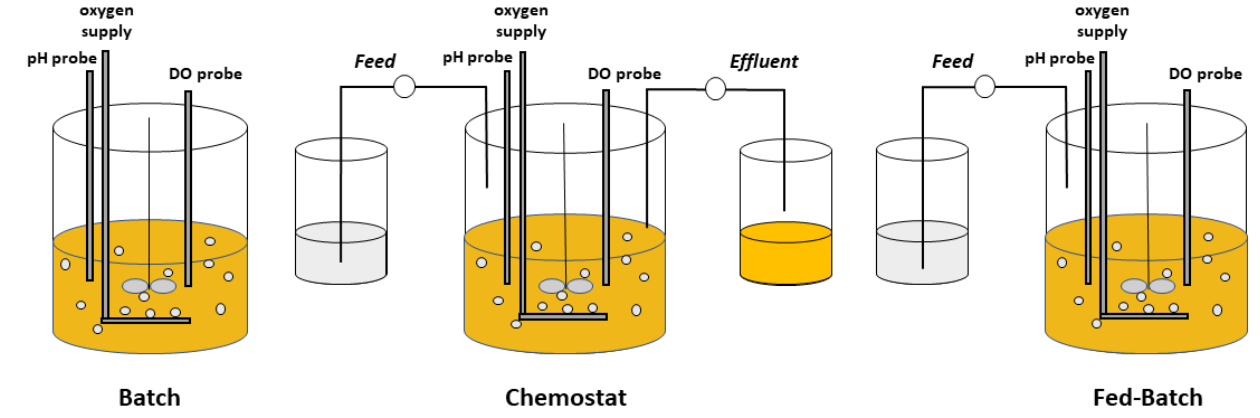
Figure 1. The three general modes of fermentation operation: batch, continuous, and fed-batch pro- cesses.